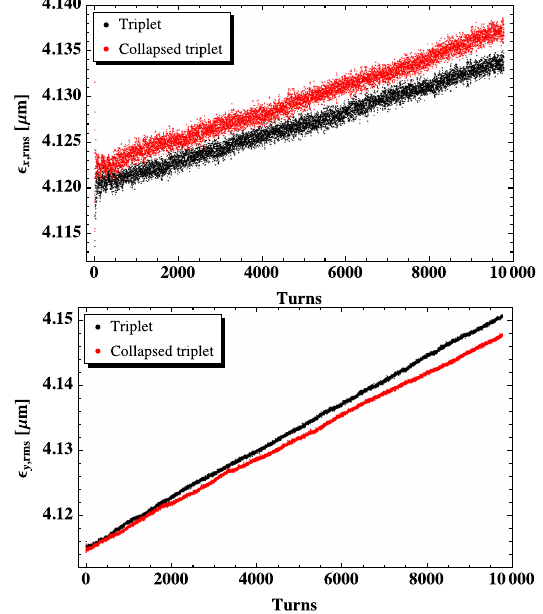
FIG. 7. Time evolution of horizontal (top) and vertical (bottom) rms emittance for the triplet and collapsed triplet cell